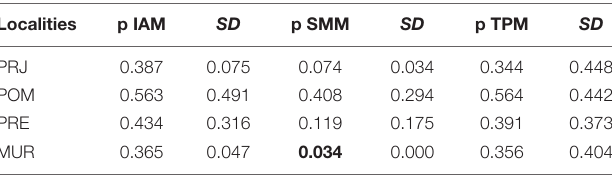
TABLE 2 | Results of the BOTTLENECK 1.2.02 program (Cornuet and Luikart, 1997) used to evaluate the possibility of changes in the effective size of the population. 1